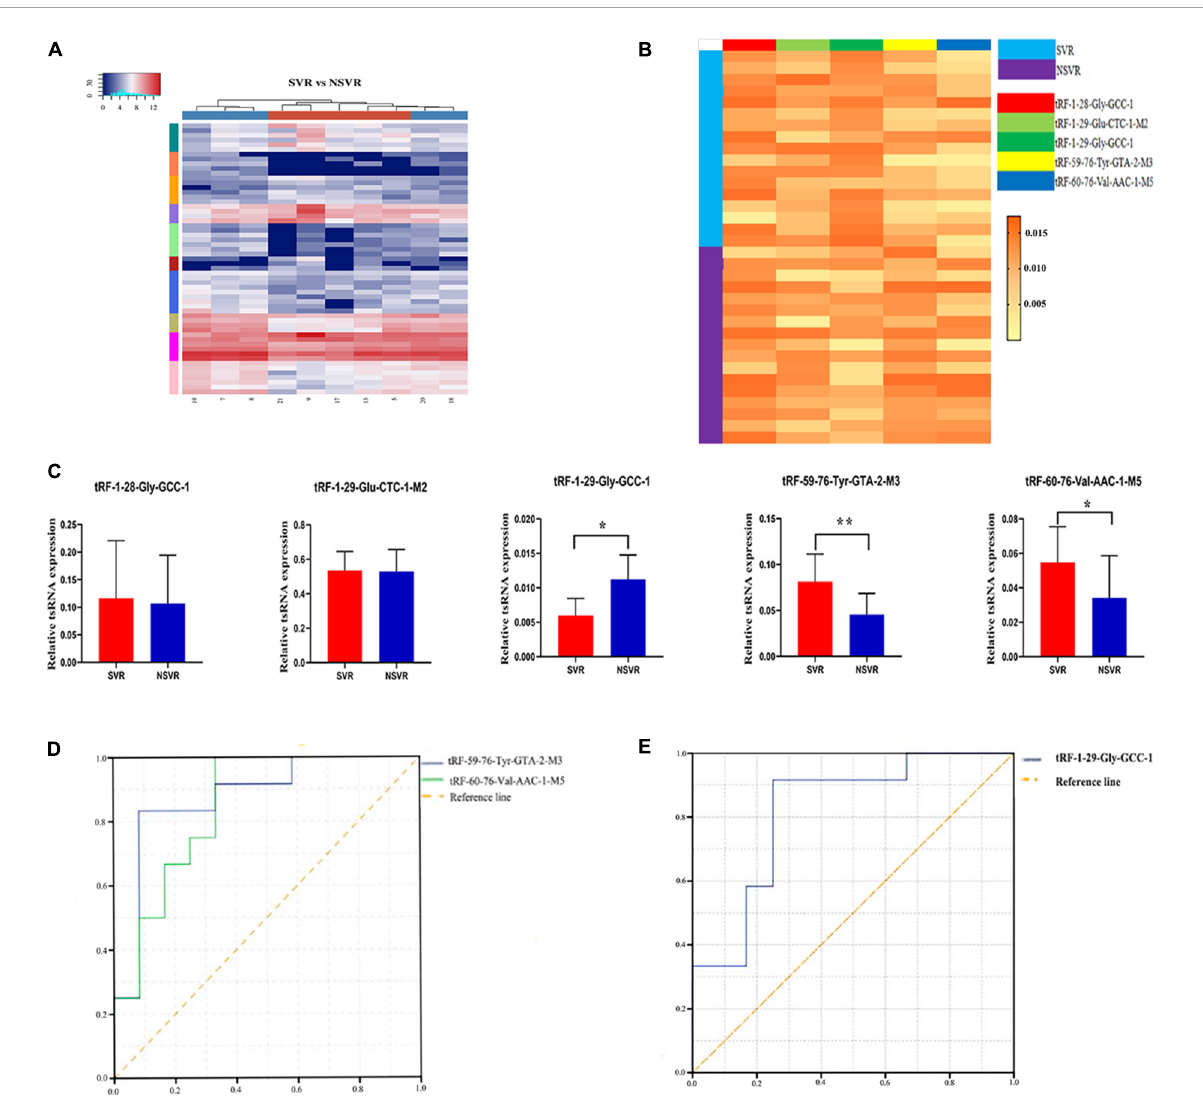
FIGURE2 Identification of SVR-related tsRNAs and qPCR confirmation. (A) Unsupervised hierarchical clustering heatmap of tRFs and tiRNAs. The color in the panel represents the relative expression level (log 2 -transformed). The color scale is show below: blue represents an expression level below the mean, and red represents an expression level above the mean. The colored bar top at the top panel showed the samples group, and the colored bar at the right side of the panel indicated the divisions which were performed using K -means. (B) The heatmap of five treatment-related tsRNAs in 17 SVR and 17 NSVR (tRF-1:28-Gly-GCC-1, tRF-1:29-Glu-CTC-1-M2, tRF-1:29-Gly-GCC-1, tRF-59:76-Tyr-GTA-2-M3, and tRF-60:76-Val-AAC-1-M5). The color in the panel represents the relative expression level (log 2 -transformed). The color scale is show below: yellow represents an expression level below the mean, and orange represents an expression level above the mean. (C) Real-time PCR verification results of five treatment-related tsRNAs in 17 SVR and 17 NSVR. * P -value < 0.05, ** P -value < 0.01. (D) ROC curve of upregulated tsRNAs. (E) ROC curve of downregulated